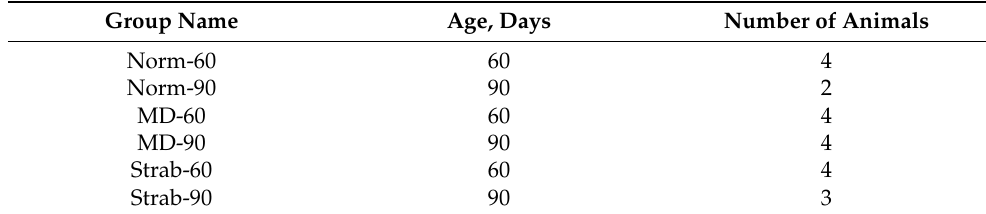
Table 1. The number of animals in the experimental